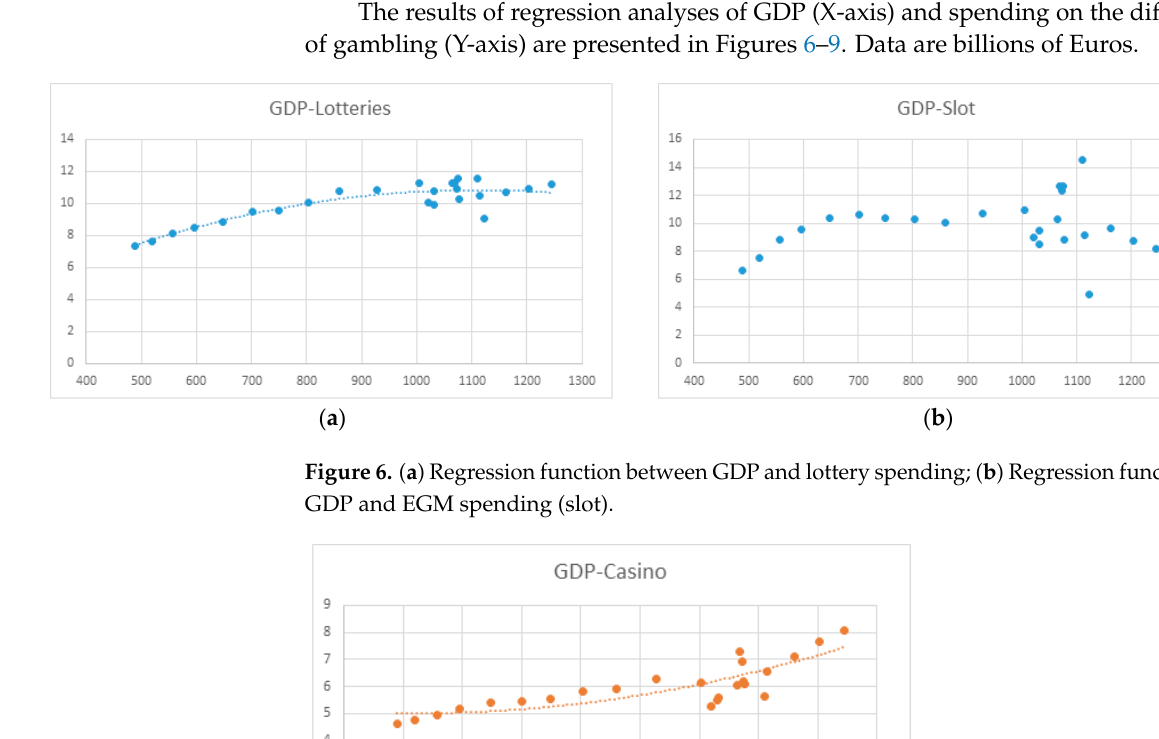
Figure 7. Regression function between GDP and casino spending. Regression analyses between GDP and lottery spending established a polynomial re- gression model: